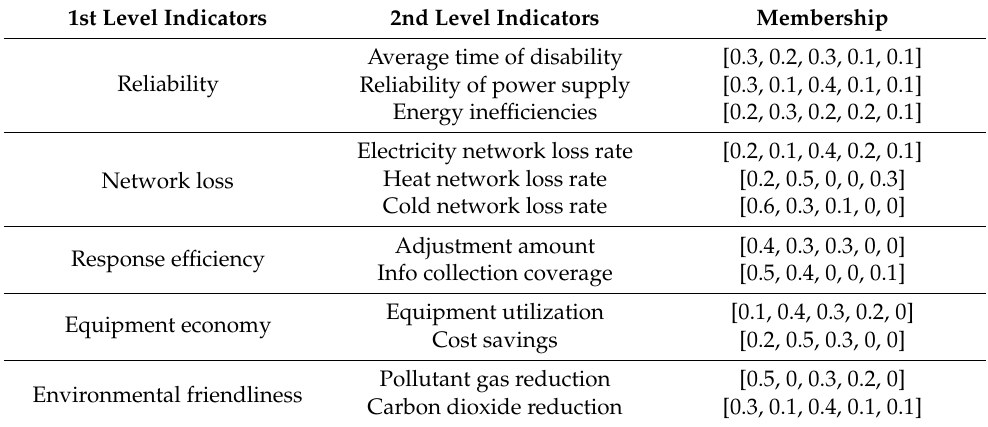
Table 4. Results of index